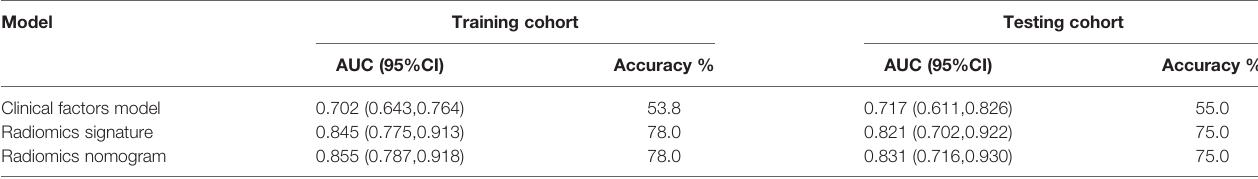
AUC, area under the